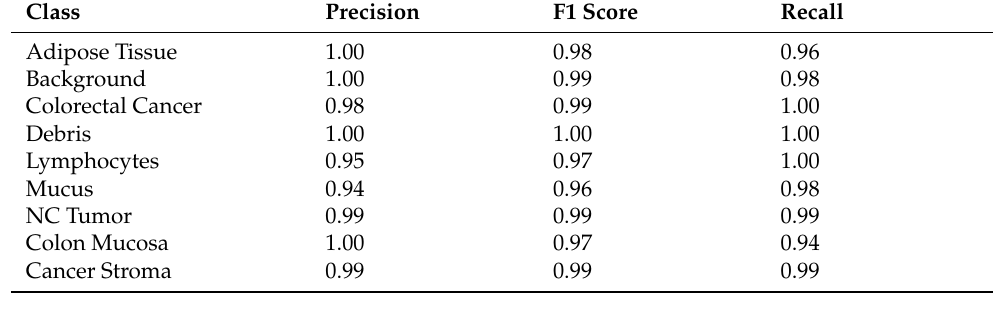
Table 8. Class-wise results representation of FabNet in terms of precision, F1 score, and recall using the NCT-CRC-HE-100K dataset.